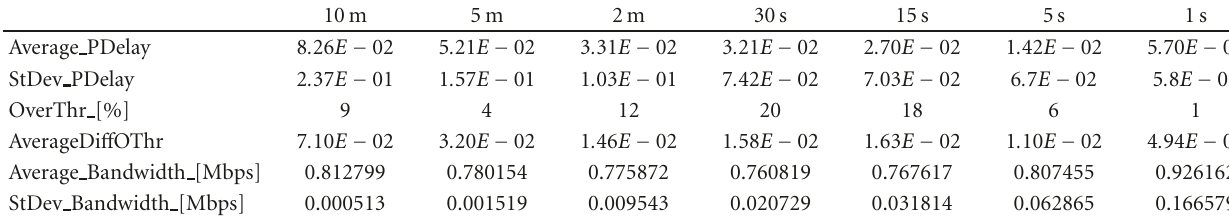
Table 3: Variable OHs with heuristic bandwidth decrease of